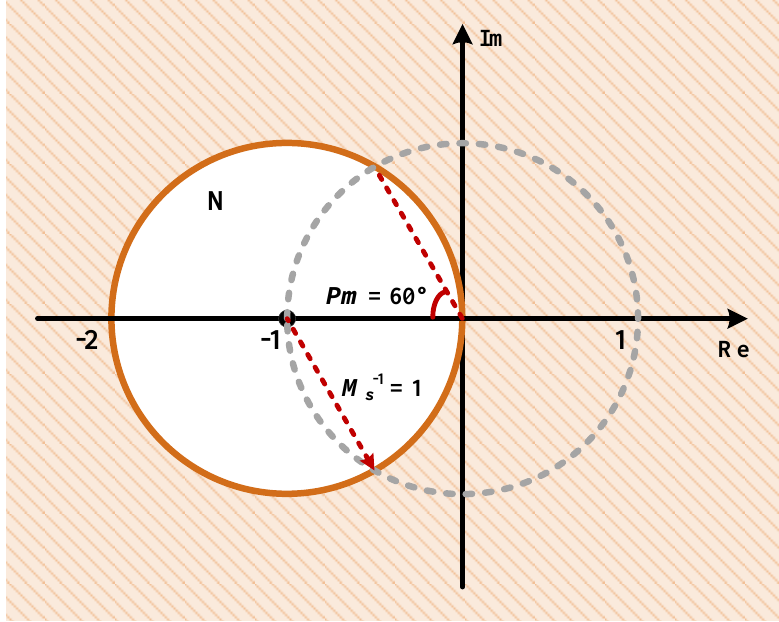
Figure 5. Geometric representation of maximum